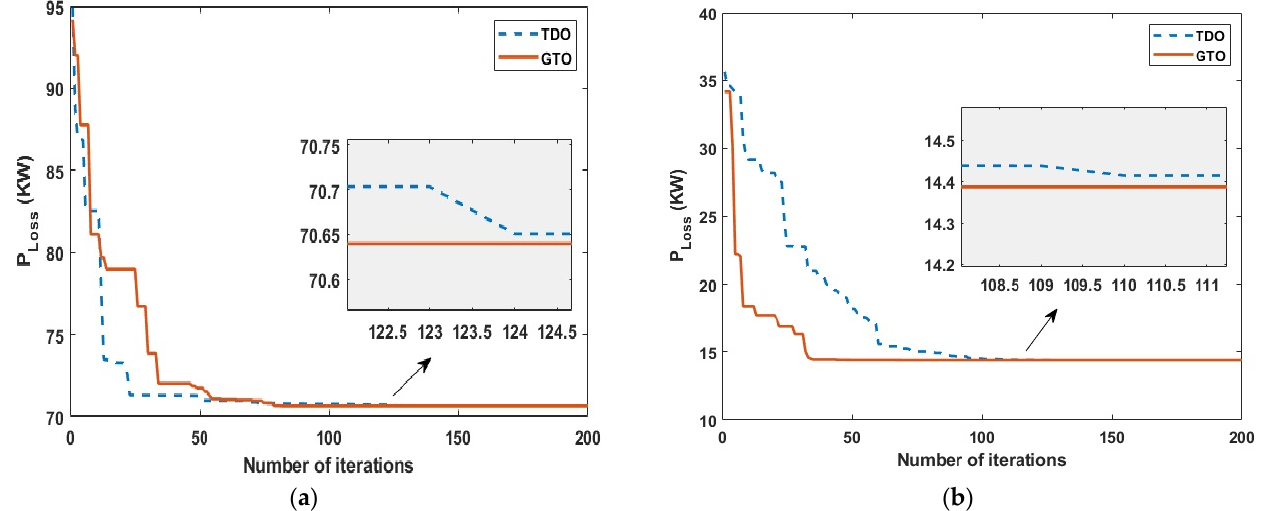
Figure 6. Convergence characteristics of the TDO and GTO algorithms for an IEEE 33-bus system under scenario 1 at different pf; ( a ) unity pf ( b ) 0.85 pf.